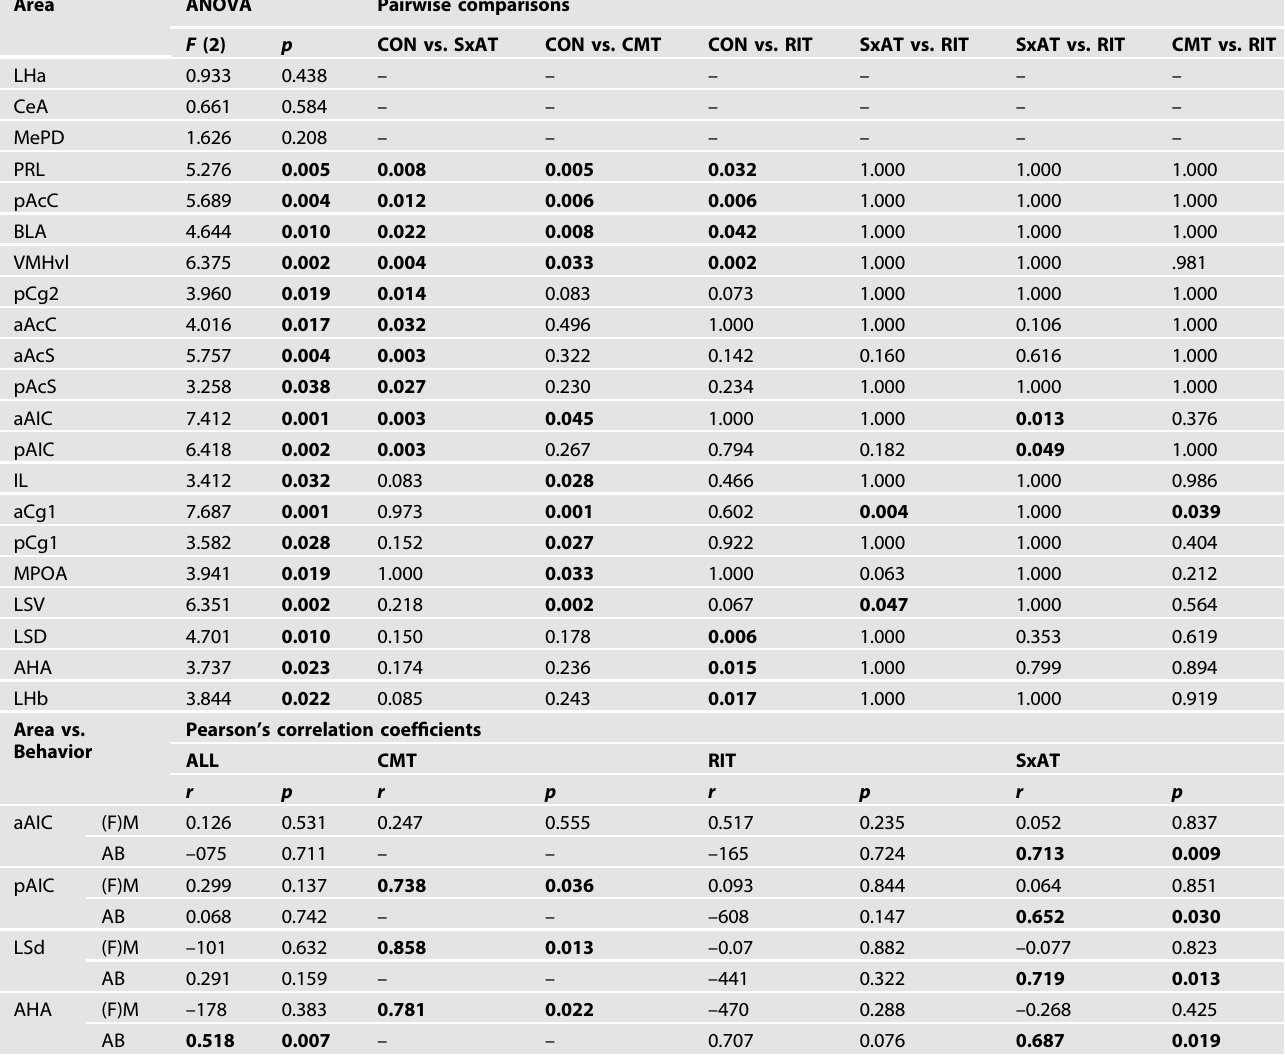
Table 4. Overview of ANOVA and, if appropriate, post-hoc pairwise comparisons of Fos-IR in various brain regions in response to the experimental conditions (Control, SxAT, CMT, RIT), and Pearson ’ s correlation coef fi cients between Fos-IR and individual